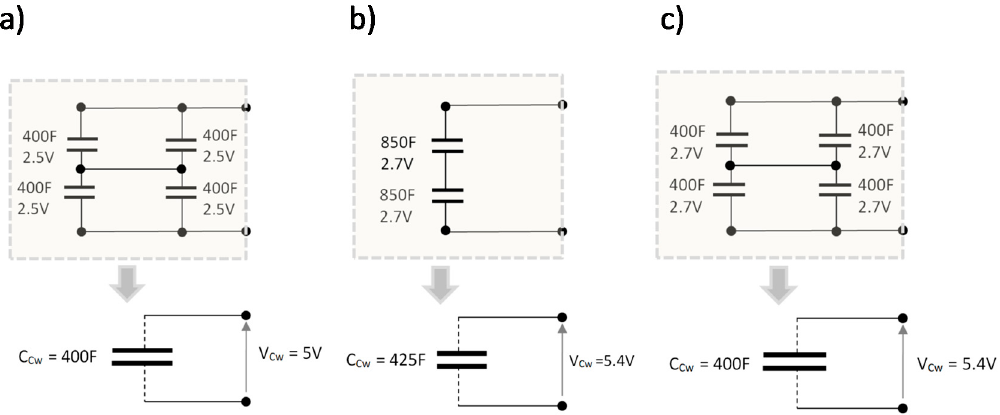
Figure 1. Equivalent circuits of supercapacitors presented in Table S1: XB3560-2R5407-R ( a ), SCCY1AB857SLBLE ( b ), and XV3560-2R7407-R ( c ).